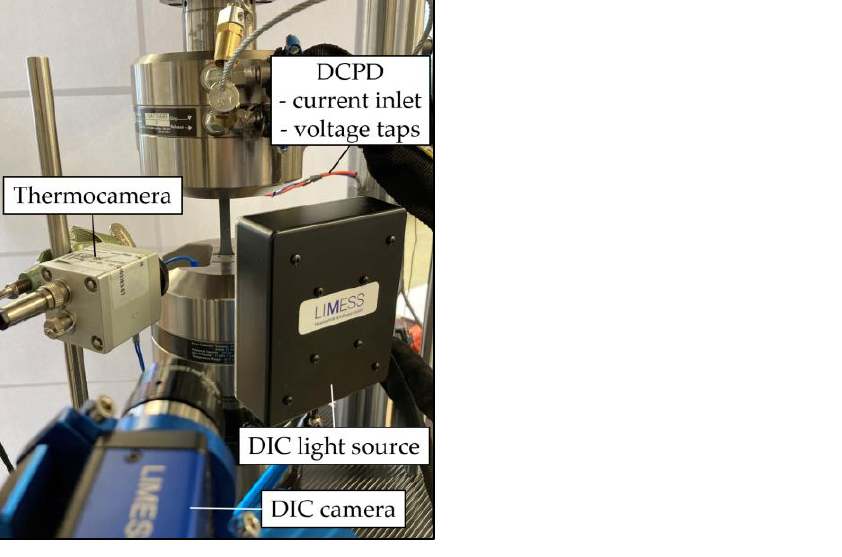
Figure 4. Experimental setup containing servo-hydraulic testing system and metrology instrumentation.